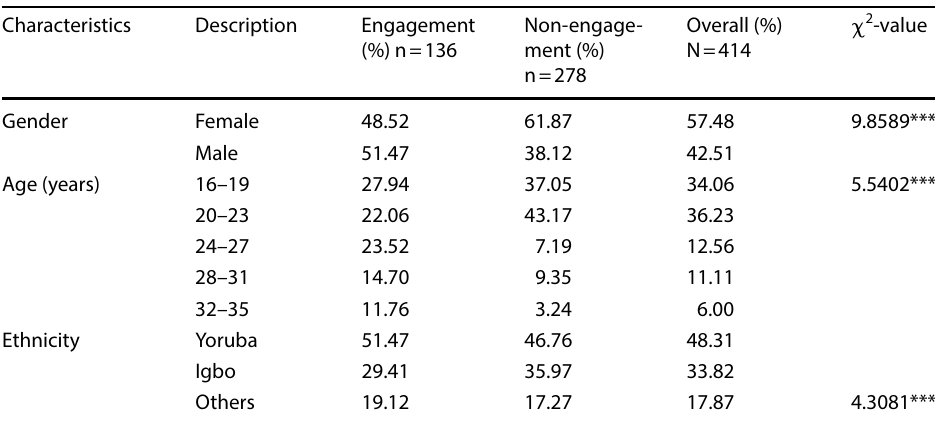
Table 1 The analysis of demographic variables and engagement in foreign habits/ behaviors